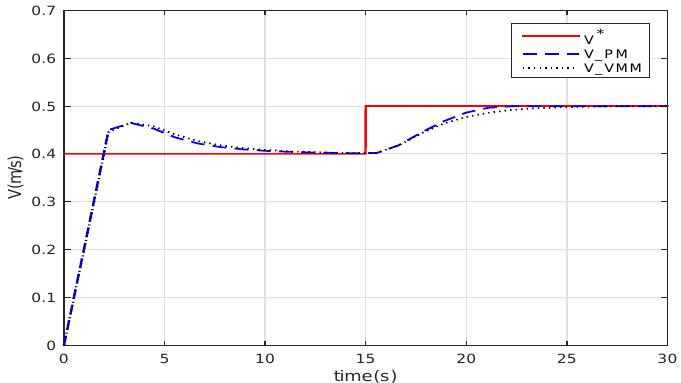
Figure 6. The forward speed of robotic fish with speed feedback of two